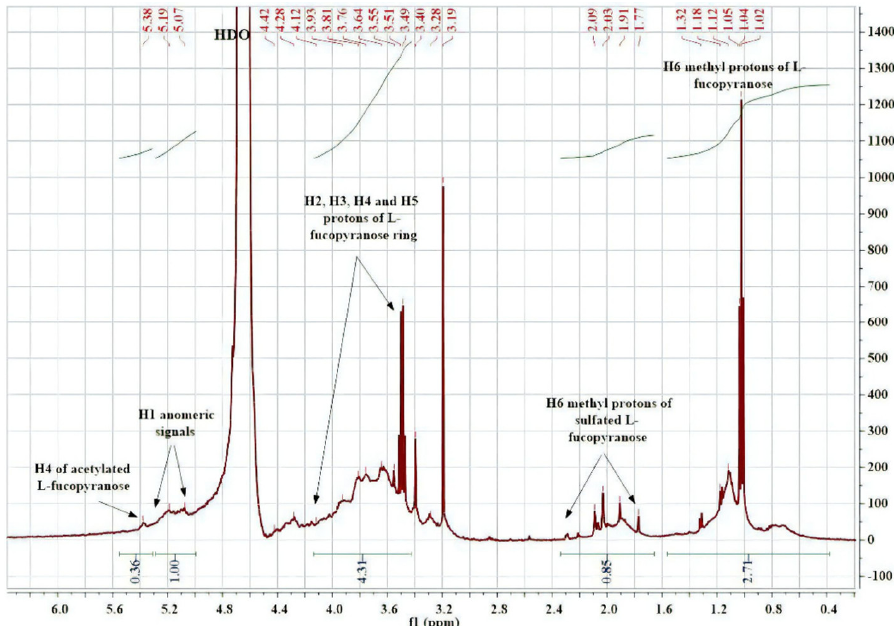
Figure 3. 1 H NMR spectrum of the extracted fucoidan polysaccharide.